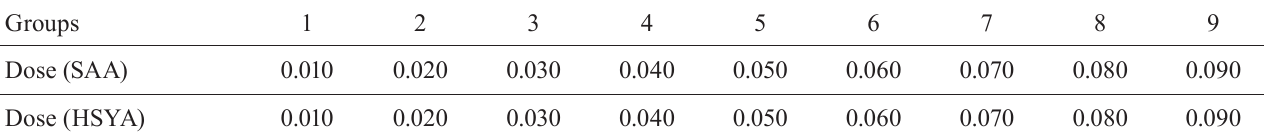
Values are means of three replicates± SE. Within a column, mean values followed by the same letter are not significantly different according to Tukey’s test (p<0.05).